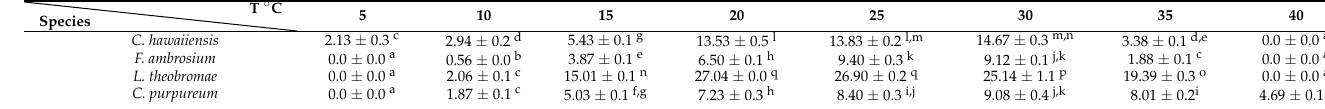
Table 2. Mycelial growth rate (mm/day) versus temperature ( ◦ C) for C. hawaiiensis , F. ambrosium , L. theobromae , and C. purpureum .